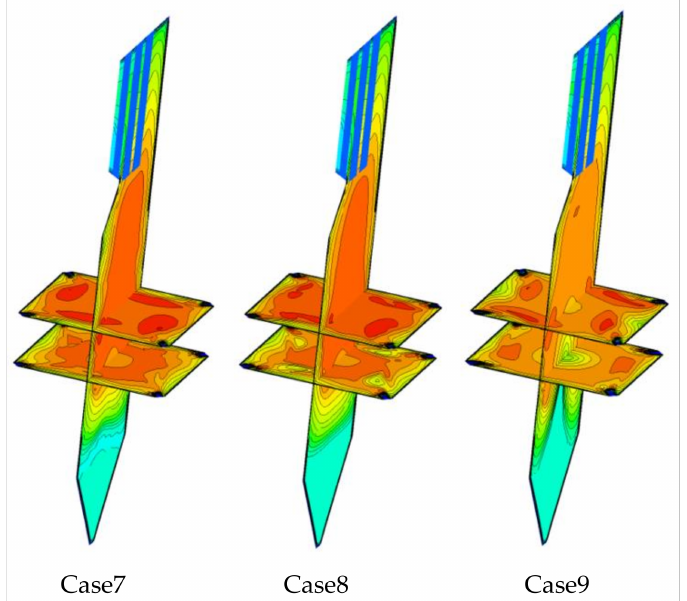
Figure 7. Temperature distribution of P1, P2 and P3 sections in the furnace under nine cases (temper- ature: K).